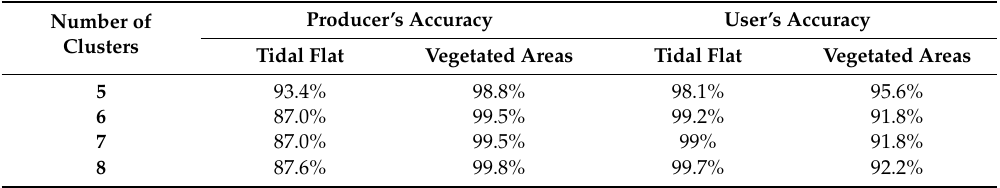
Table 6. Summary of the quantitative assessment of TLS segmentation results for tidal flats and areas covered by vegetation when increasing the number of clusters.